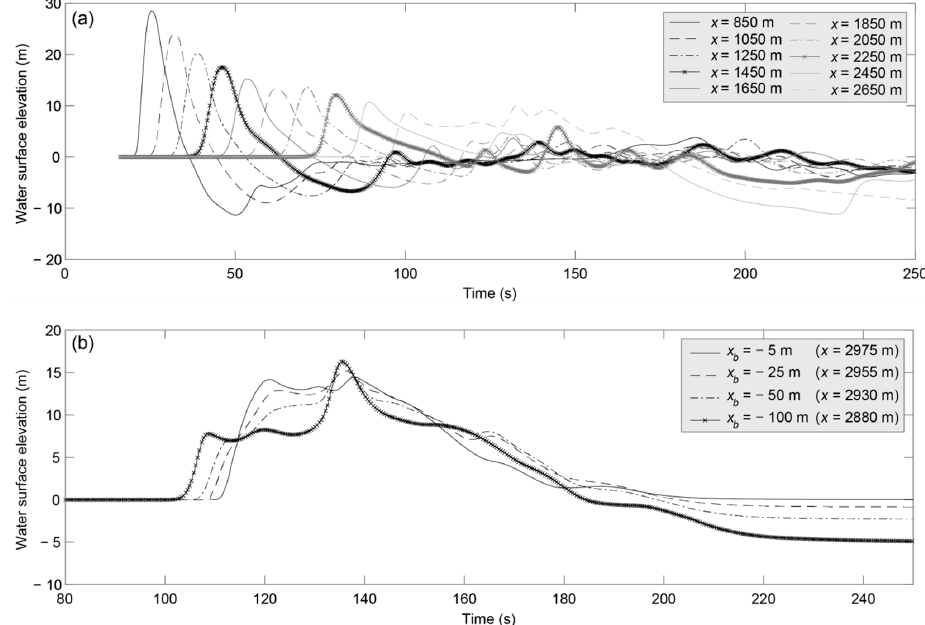
Figure 8. Time history of the water surface elevation measured along the slide axis for scenario 1; ( a ) relative to the slide impact point ( x = 0 m) and ( b ) relative to Cala d’Hort ( x b = 0 m and x = 2980 m).